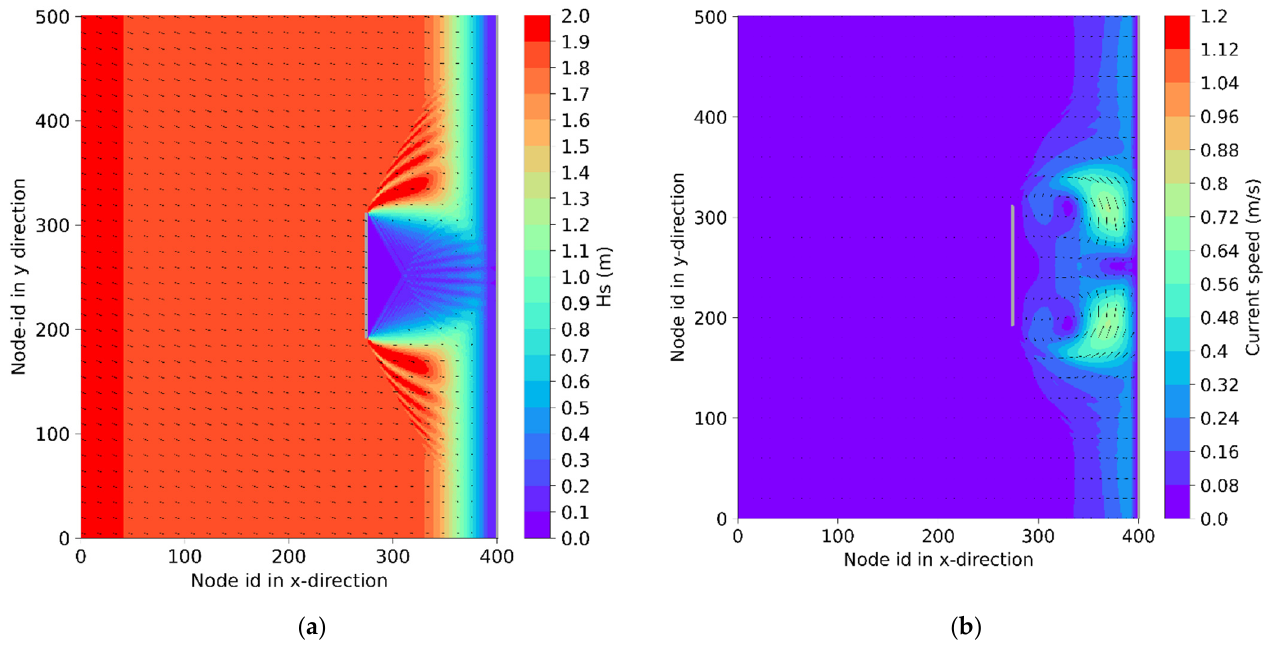
Figure 7. Spatial distribution of ( a ) significant wave height simulated with PMS and ( b ) hydrodynamic circulation simulated with HYD, for the idealized case with slope 1:50.